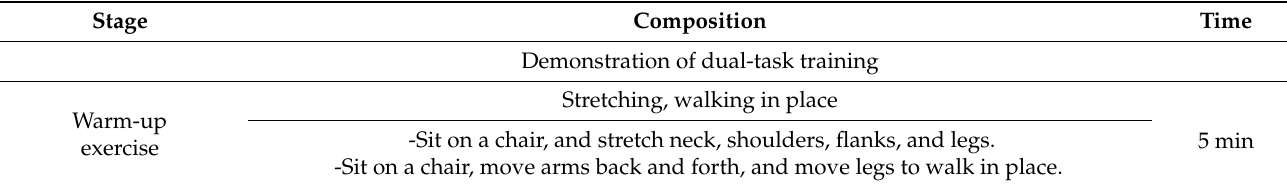
Table 1. The composition of cognitive/exercise dual-task